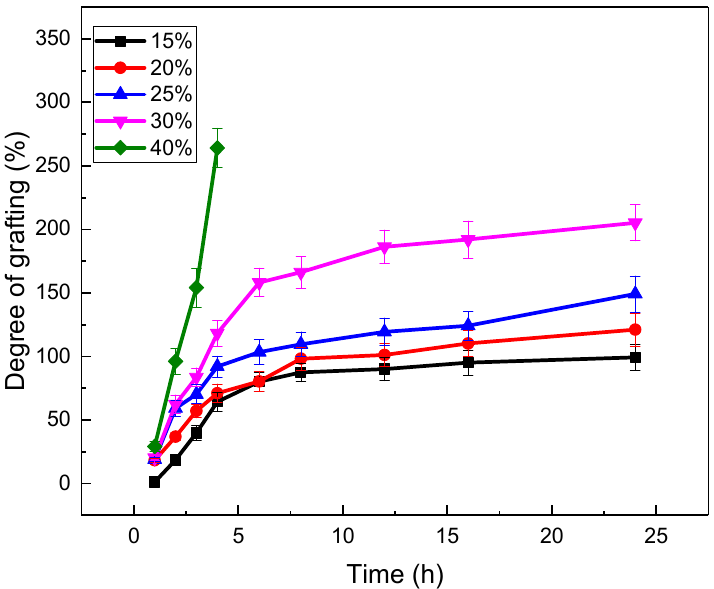
Figure 4. The degree of grafting of AAm versus the reaction time in the comparison of the monomer concentration (AAm was grafted at 60 °C, and the absorbed dose of the PP sheets was 200 kGy).